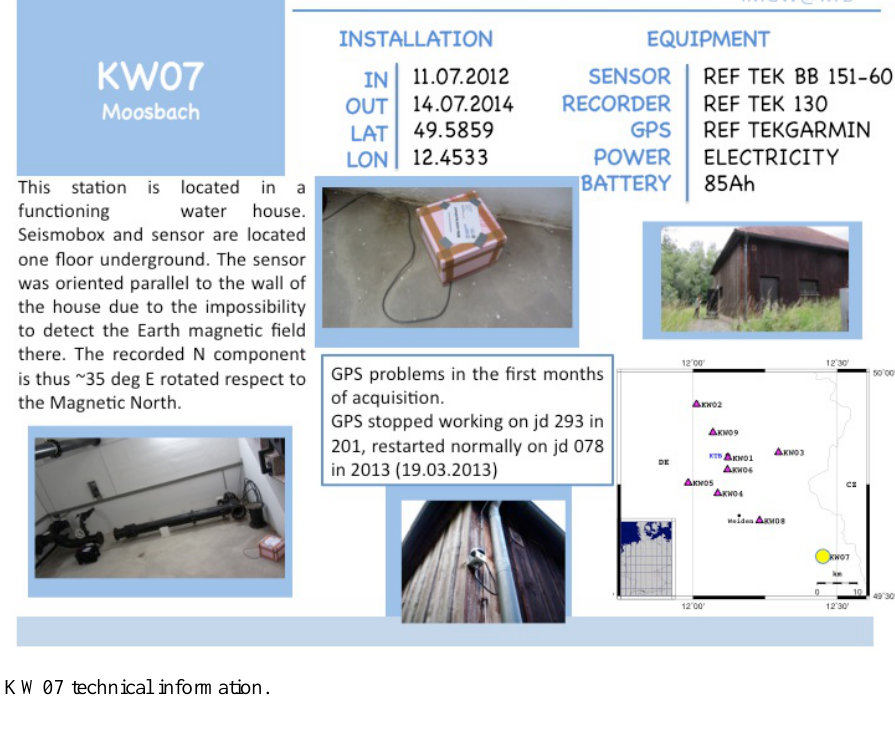
Figure A7. Station KW07 technical information.